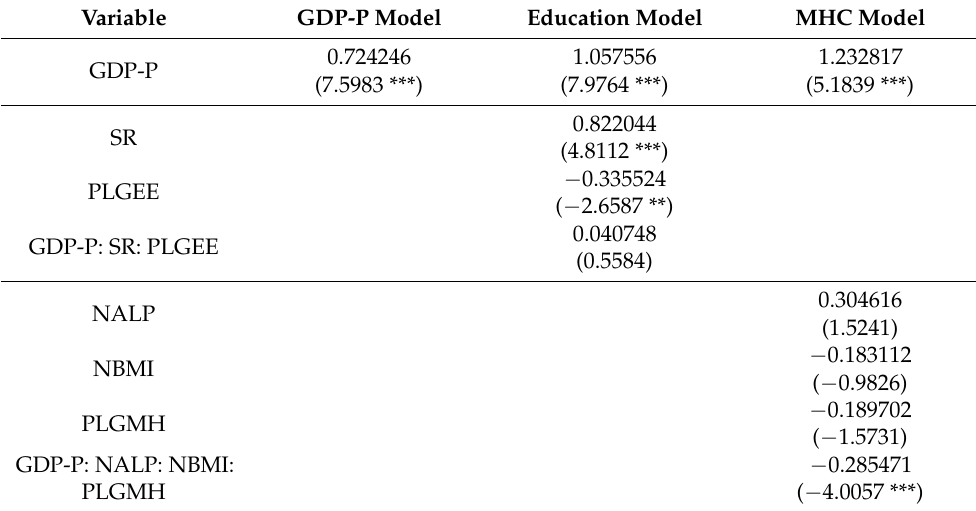
Table 9. Fixed Model results of positive emotions and GDP-P, Education and MCH model.